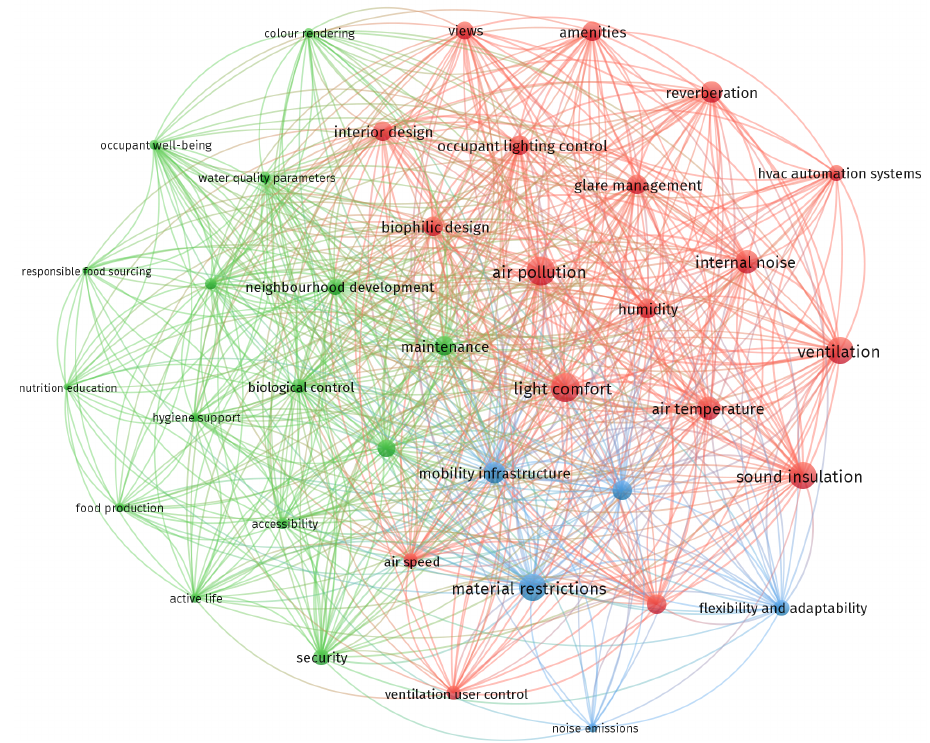
Figure 2. Semantic diagram of certification documents